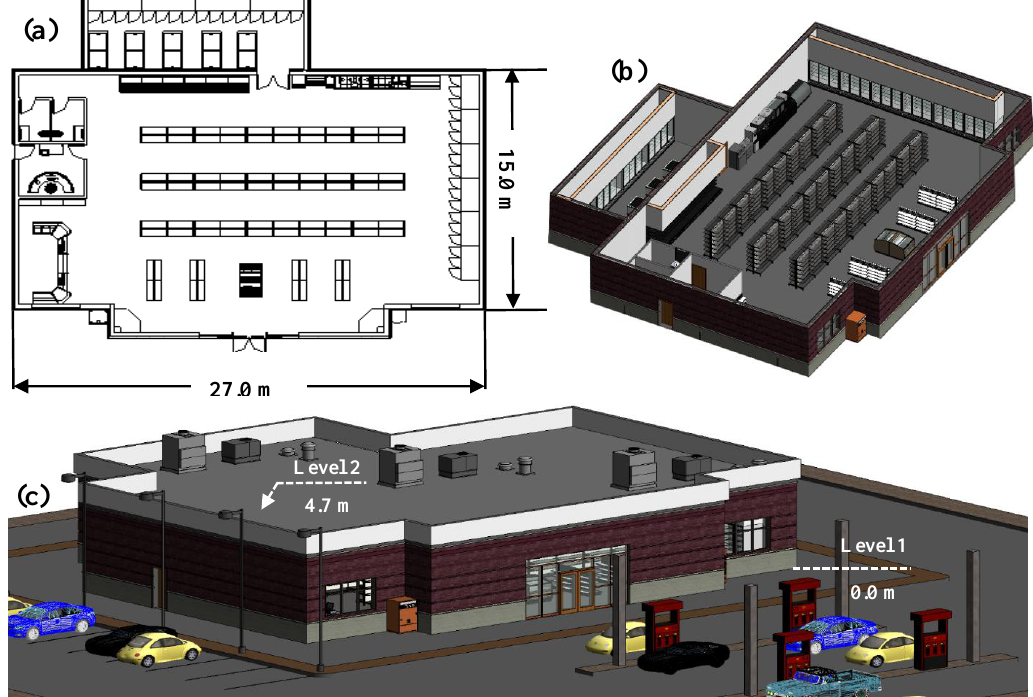
Figure A5. F5 archetype plans and sections: ( a ) Plan view; ( b ) 3-D view for the store; ( c ) 3-D view for the whole gas station.